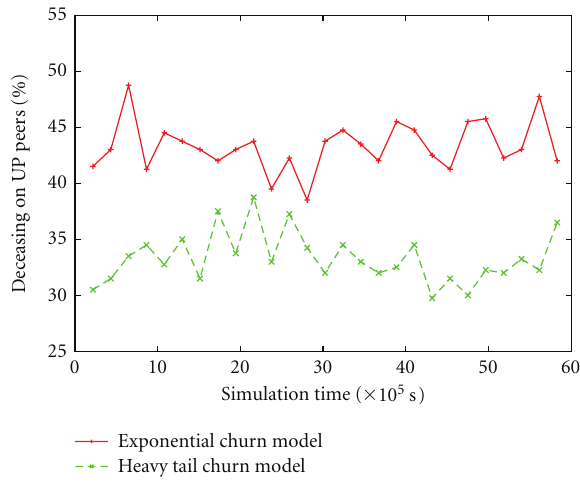
Figure 8: The decreasing on number of UP